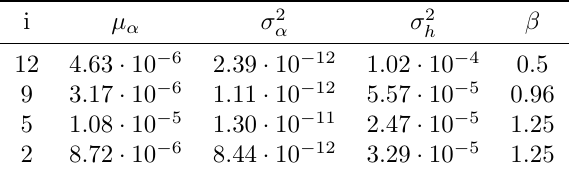
Table 1: Initial PF parameter values for test rig 1 ex-